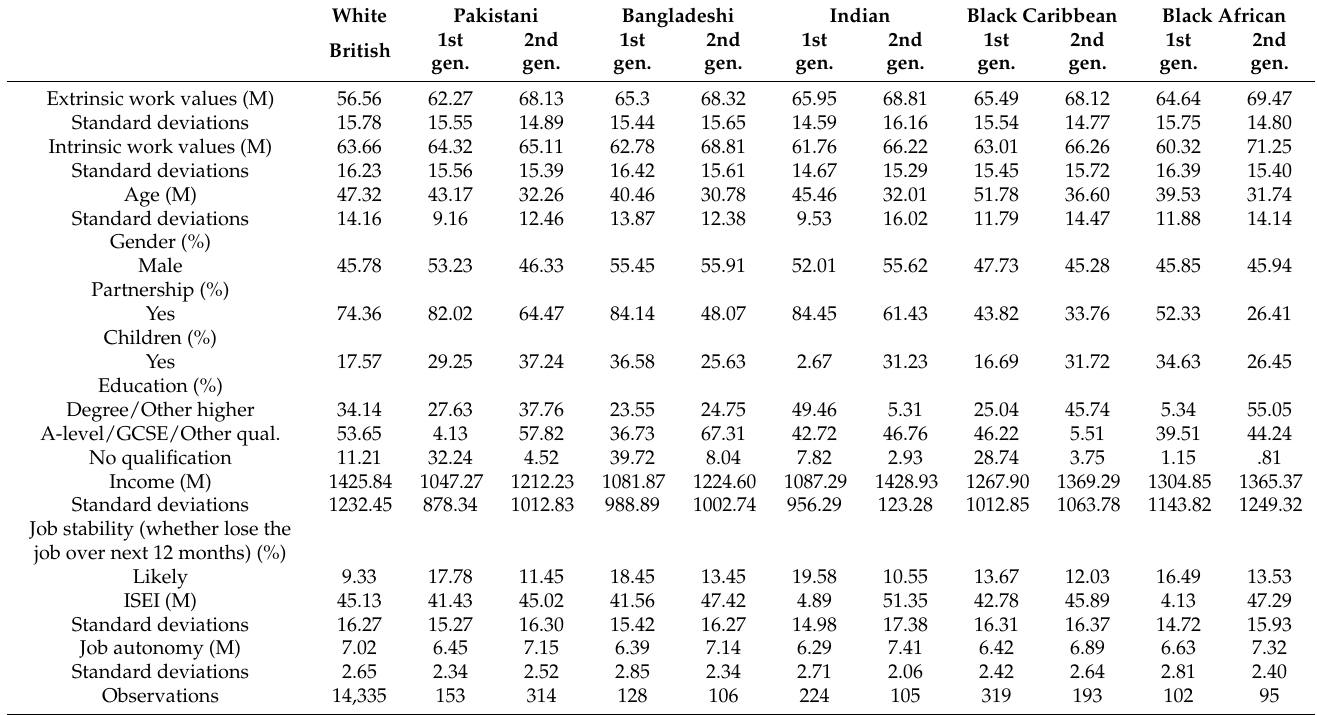
Table 1. Descriptive Statistics by Ethnic and Generational